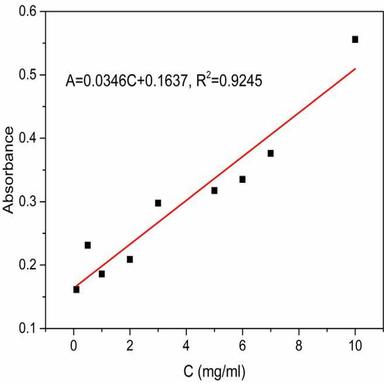
Fitting chart of absorbance of silica at different concentrations.